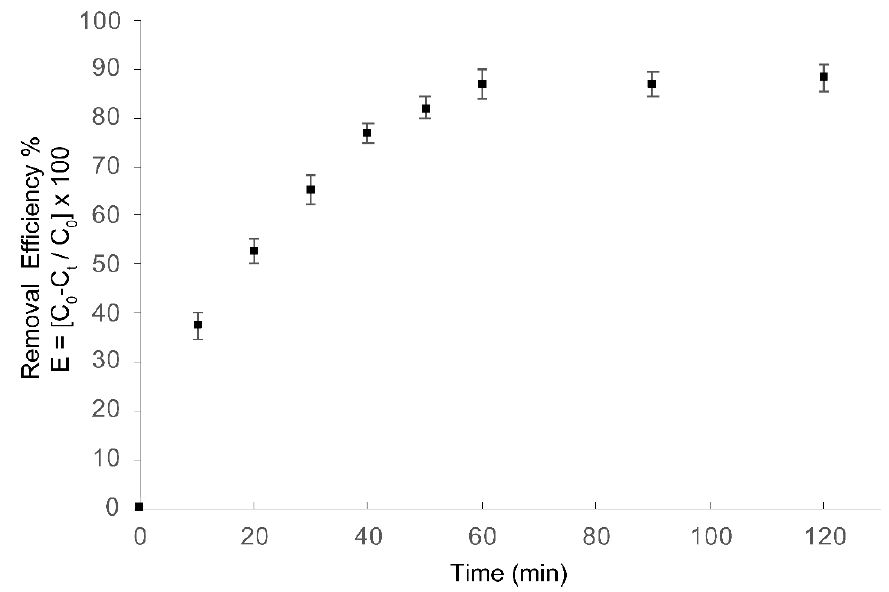
Figure 4. Chemical oxygen demand (COD) removal efficiency for azo dye Carmoisine (5 ppm) as a function of treatment time. ( ) Electro-oxidation (EO) process. The current density was 30 mA·cm −2 , the pH of the sample was adjusted to 5.2. Treated volume 1.1 L.